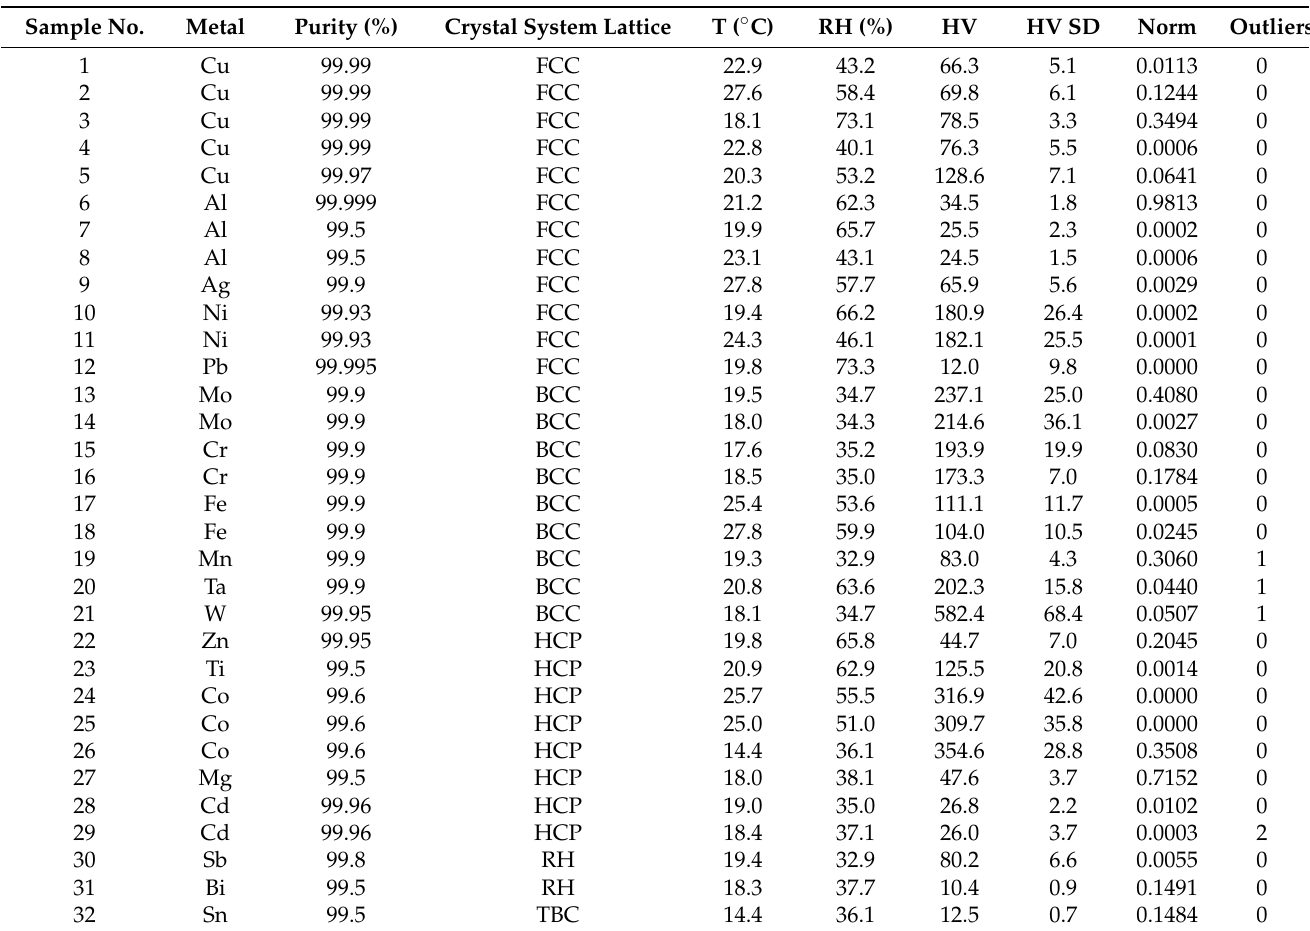
Table 1. Tested metals, their purity, the crystal system lattice, ambient temperature and relative humidity of laboratory, average hardness HV, standard deviation of average hardness HV SD, normality ( p -value), and outliers of the